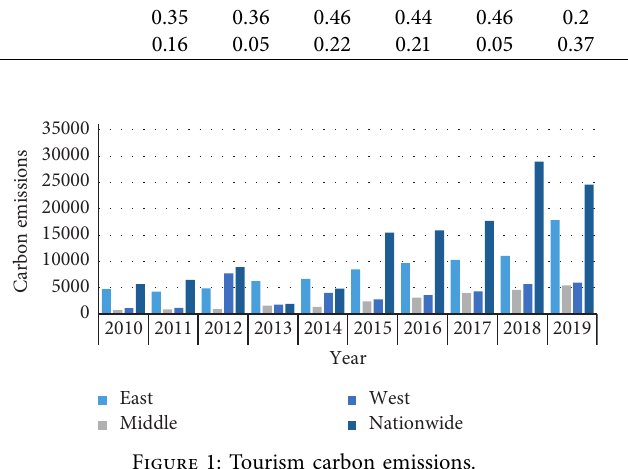
Figure 1: Tourism carbon emissions.